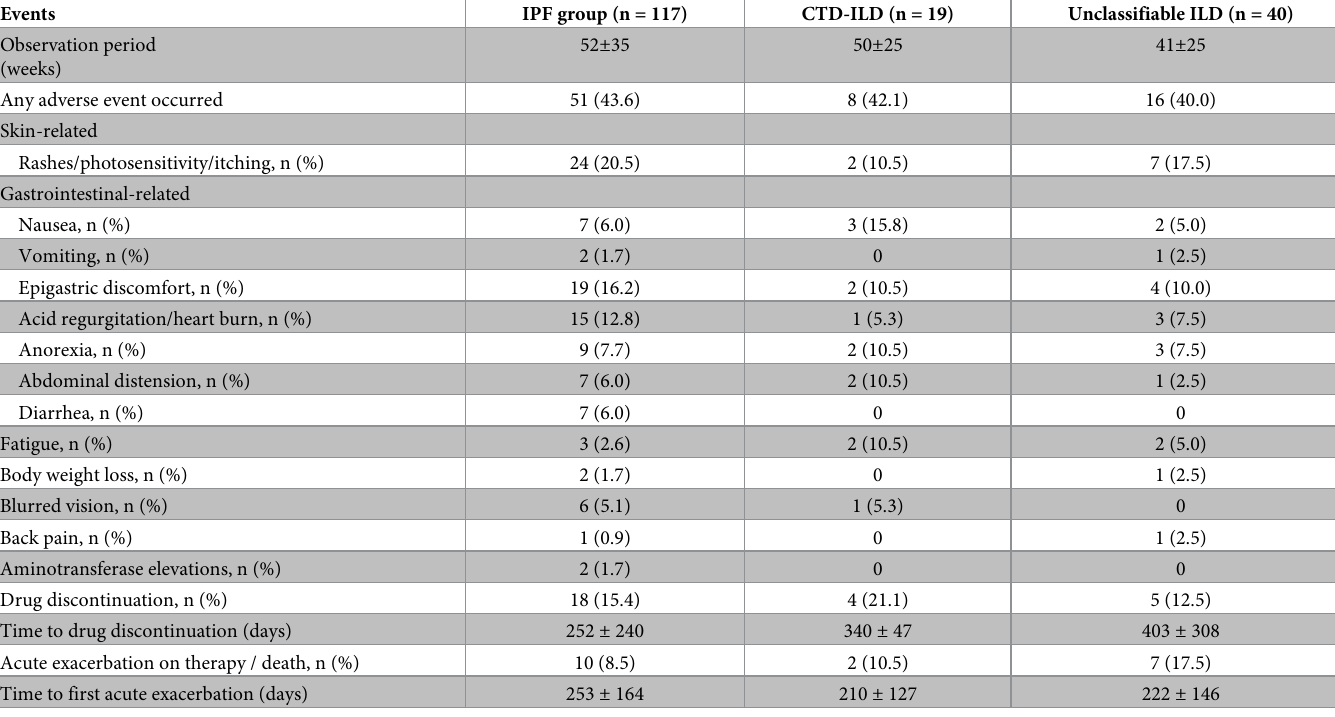
Table 5. Adverse reactions, drug discontinuation and acute exacerbation